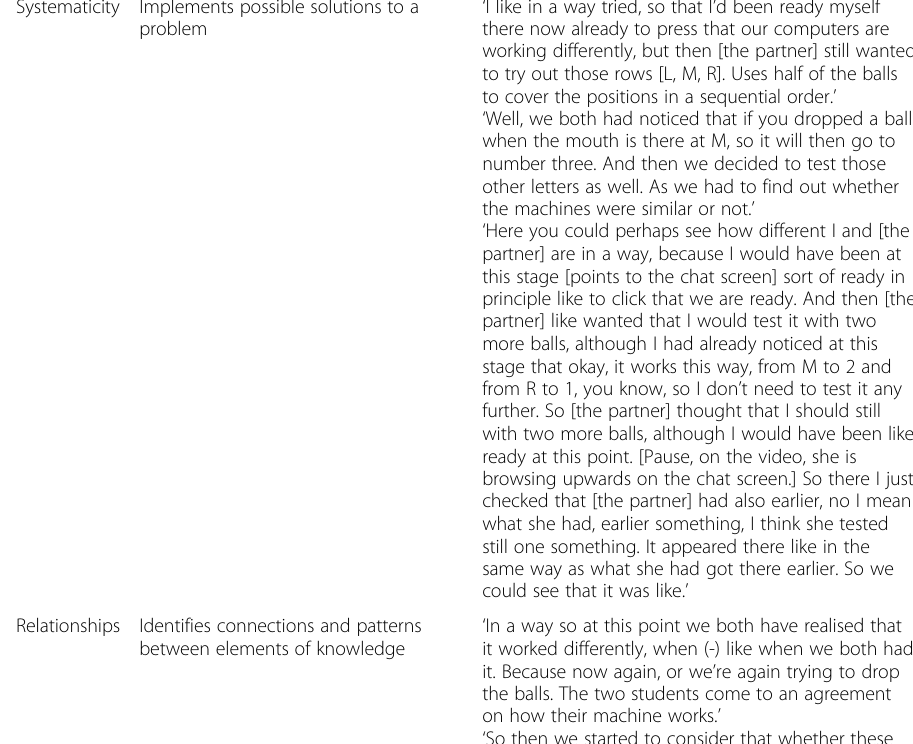
Table 9 Examples of the coded primary data from the cued retrospective reporting (CRR) data (from the Laughing Clowns task) (Continued) Skill/element Behaviour indicator (as assessed in An example of the CRR data captured for coding the ATC21S environment) the category in the Laughing Clowns task Systematicity Implements possible solutions to a